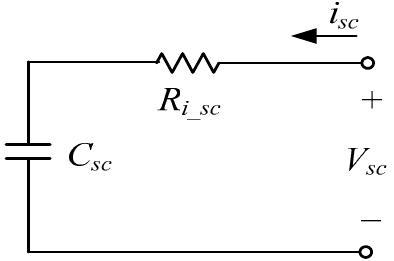
Figure 5. The equivalent electrical circuit of the supercapacitor.